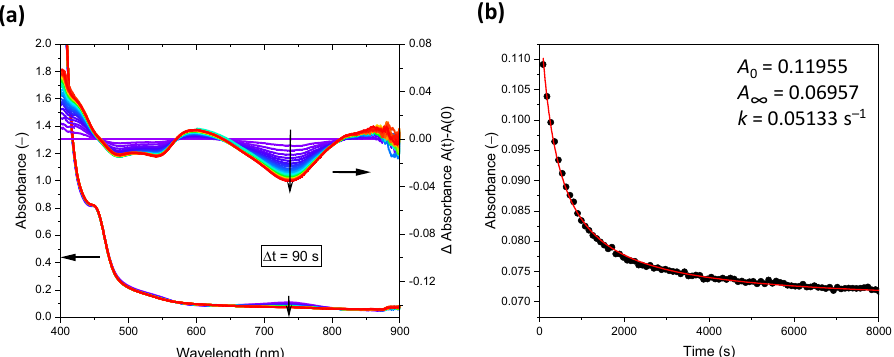
Figure 8. ( a ) Evolution of UV-vis spectra of the PPM-AgClO 4 in THF, including difference spectra (right ordinate), with time intervals of 90 s between the individual measurements (0.1 Ag + per phenylene group, 90 mg/mL); ( b ) Kinetic analysis of the evolution of the absorbance at 739 nm related to the spectra displayed in ( a ) fit to second-order kinetics (see text) between 0 s and 8000 s (red curve).